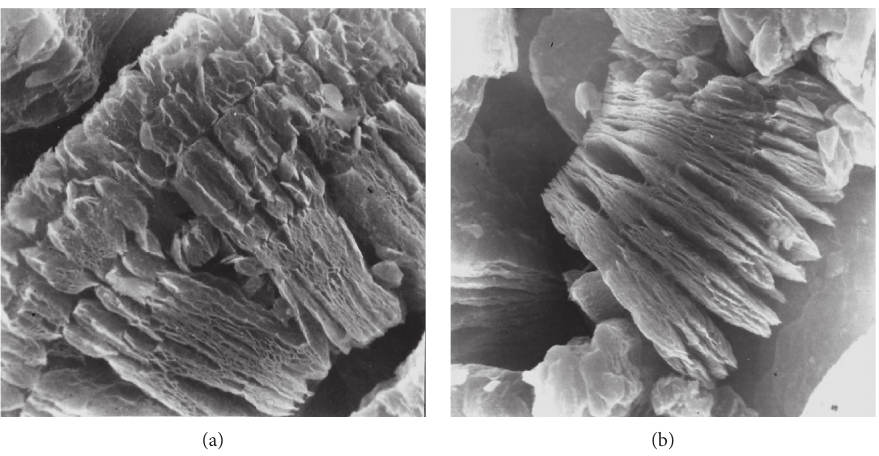
Figure 16: Graphite layered compound after the thermal shock ( × 60) (a) and ( × 100) (b).